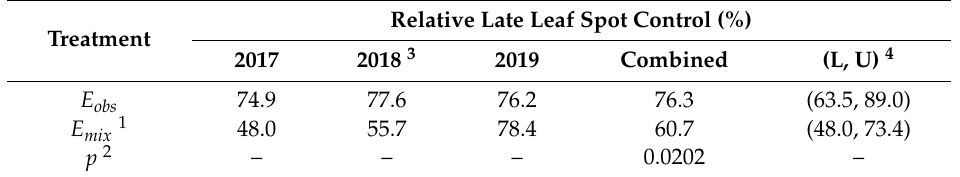
Table 2. Relative late leaf spot control e ffi cacy observed and predicted for prothioconazole at 0.11 kg / ha plus fluxapyroxad at 0.05 kg / ha plus pyraclostrobin at 0.1 kg / ha according to independent action